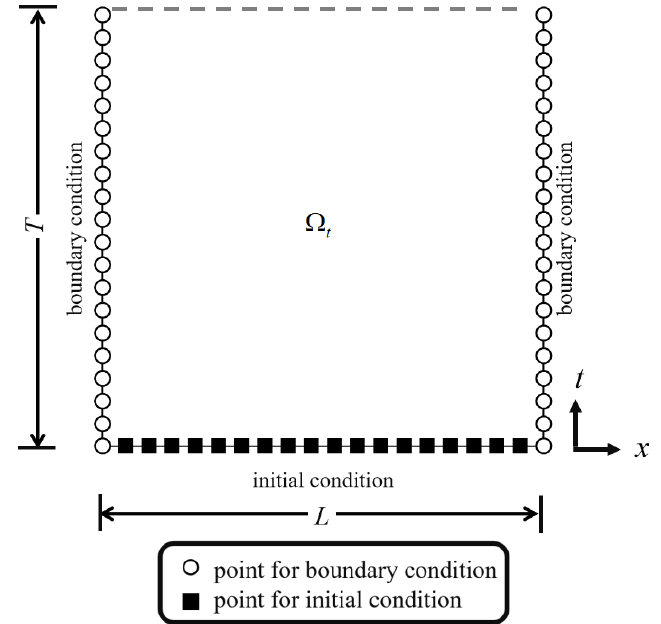
Figure 2. Illustration of one-dimensional ST method.